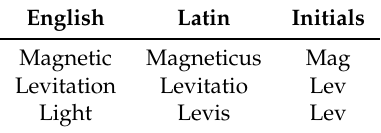
Figure 7. Track Switch. EML on the left, SML on the right. Table 3. The name MagLev 2 -Cobra.